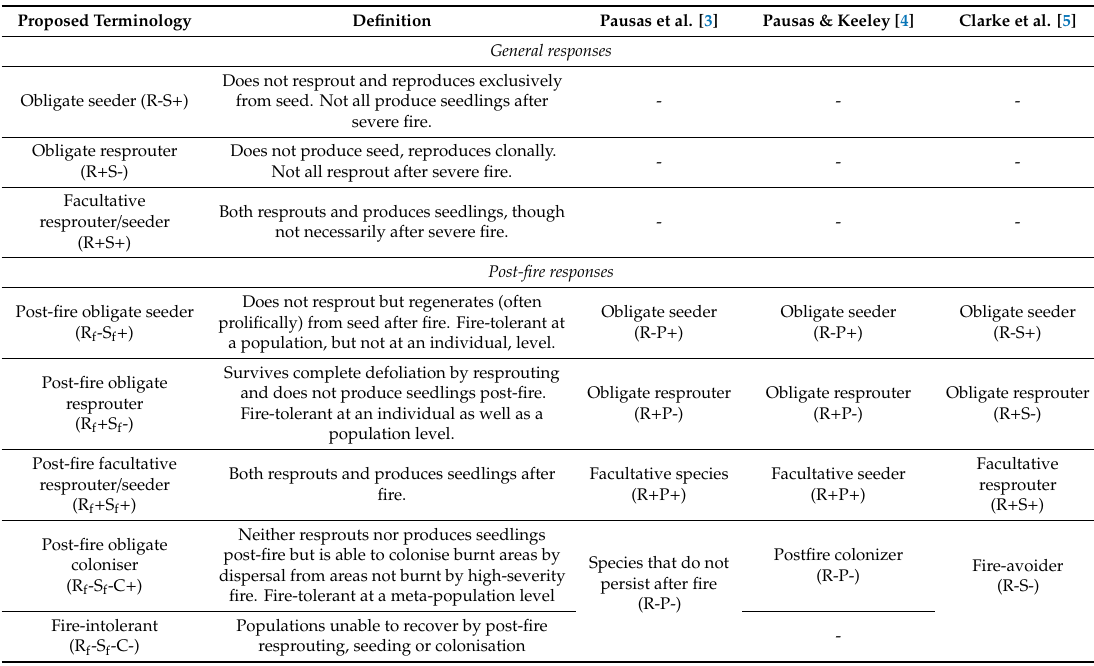
Table 1. Terminology proposed here to describe woody plant responses to canopy-defoliating fire, and comparison with earlier schemes. Relevant traits, listed in brackets, are as follows (our scheme): R is resprouter, R f is post-fire resprouter, S is seeder, S f is post-fire seeder, C is colonizer. Traits used in earlier schemes: R is post-fire resprouting; P is propagule persistence; S is post-fire